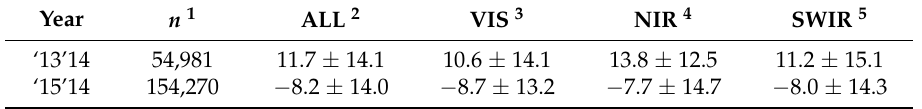
Table A1. Relative difference (%) in mean reflectance before